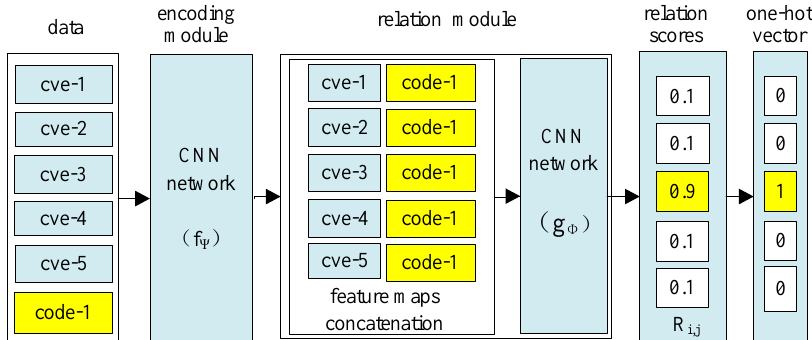
Figure 3. 5-way 1-shot model